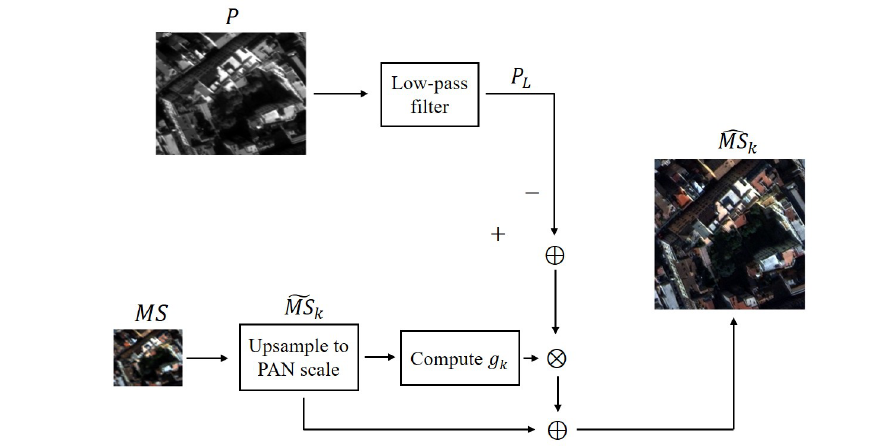
Figure 2. Flowchart of the MRA-based methods for